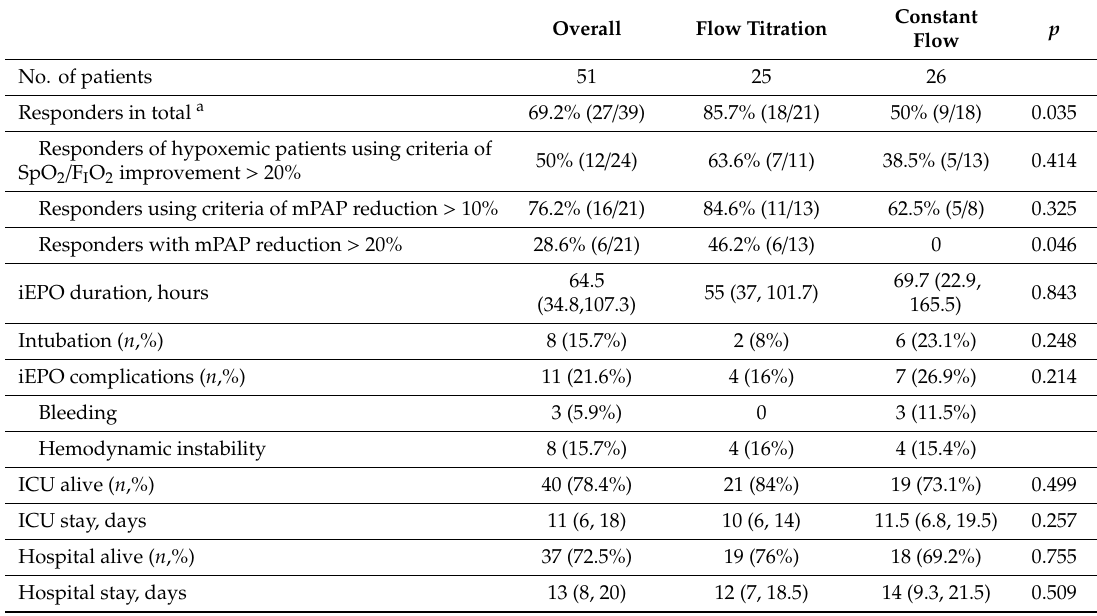
Table 5. Comparisons outcome for patients receiving titrated flow and constant